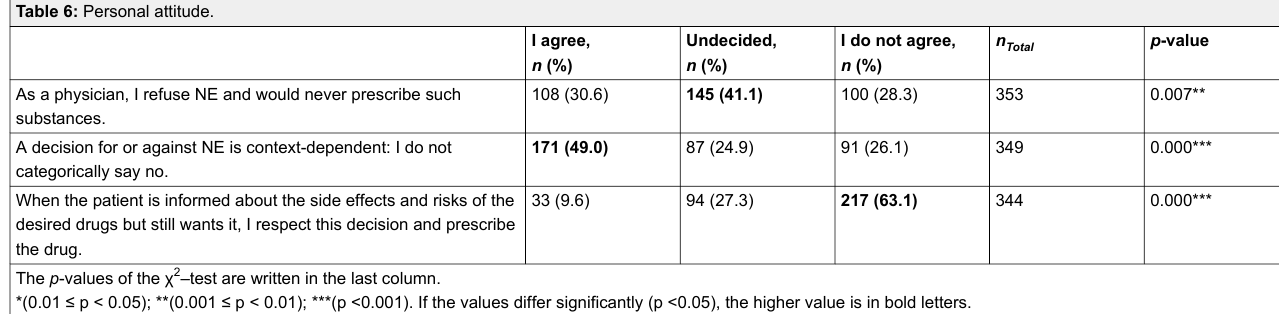
Table 7: Which criteria influence your decision regarding the prescription of drugs in the different scenarios (multiple answers possible)? Yes, n (%) No, n (%) n Total p -value The subjective suffering is intense.